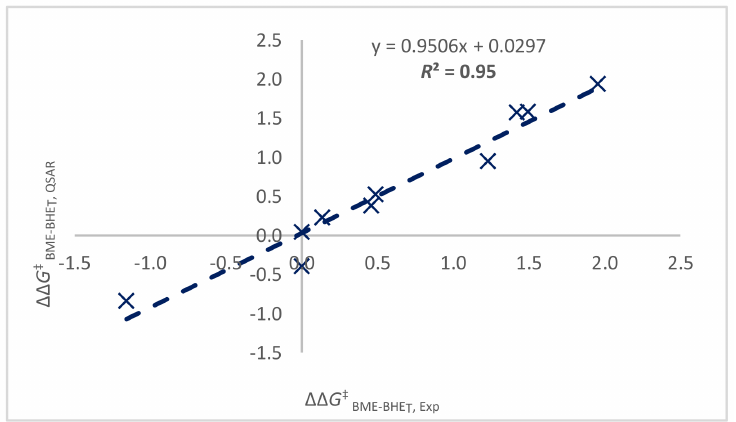
Figure 3. Correlation of experimentally observed ratio of allyl to vinyl chain ends (modeled as ∆∆ G ‡ ◦ C and QSAR-predicted ratio ( ∆∆ G ‡ BME-BHET, Exp ) at 100 BME-BHET, QSAR ) for catalysts Hf-1 to Hf-5 and Zr-1 to Zr-5 .